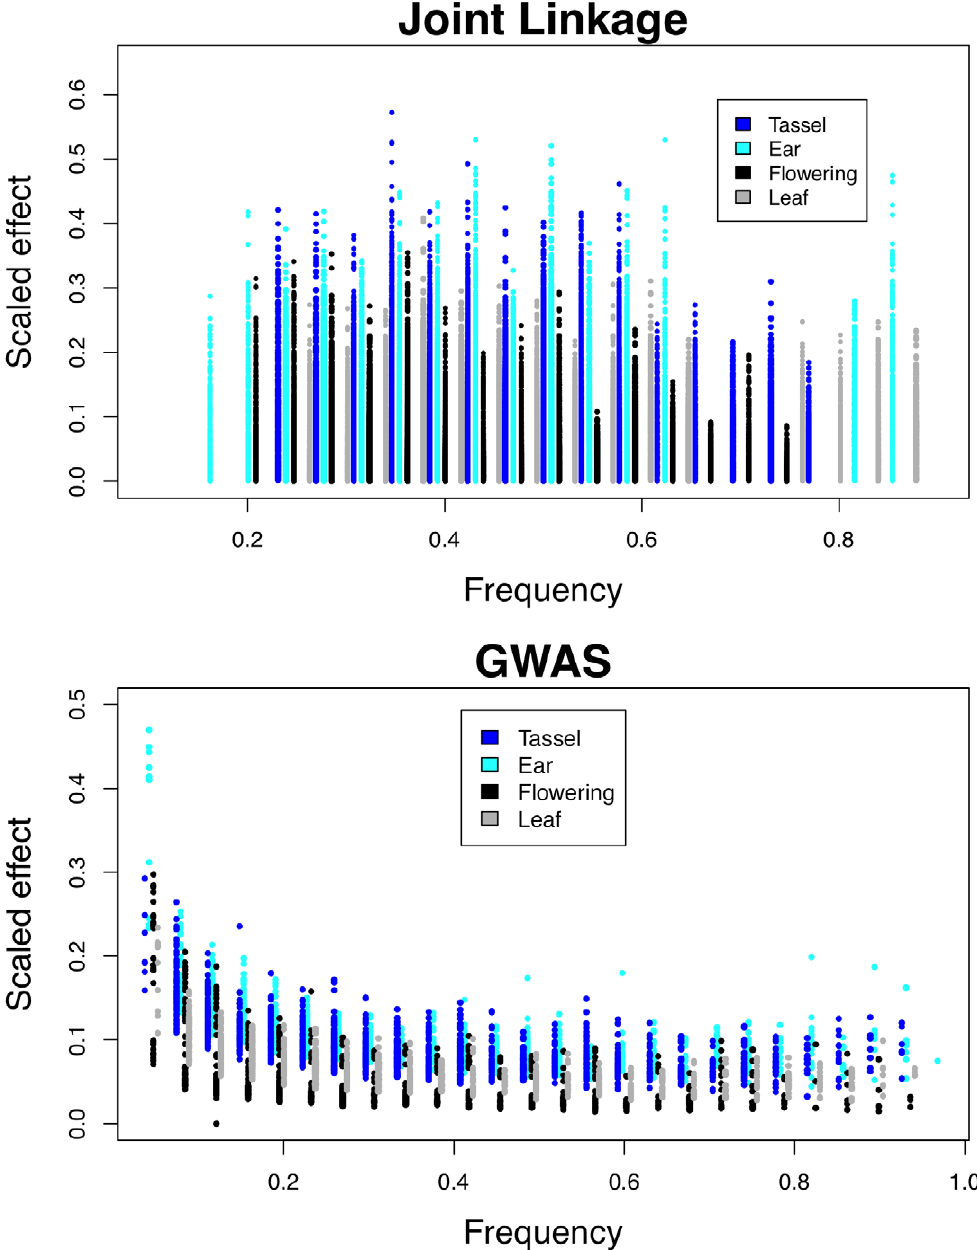
Figure 3. Relationship between QTL frequencies and effects. Effects from joint linkage (top) and GWAS (bottom) analyses are grouped by trait categories and scaled as in Figure 2.